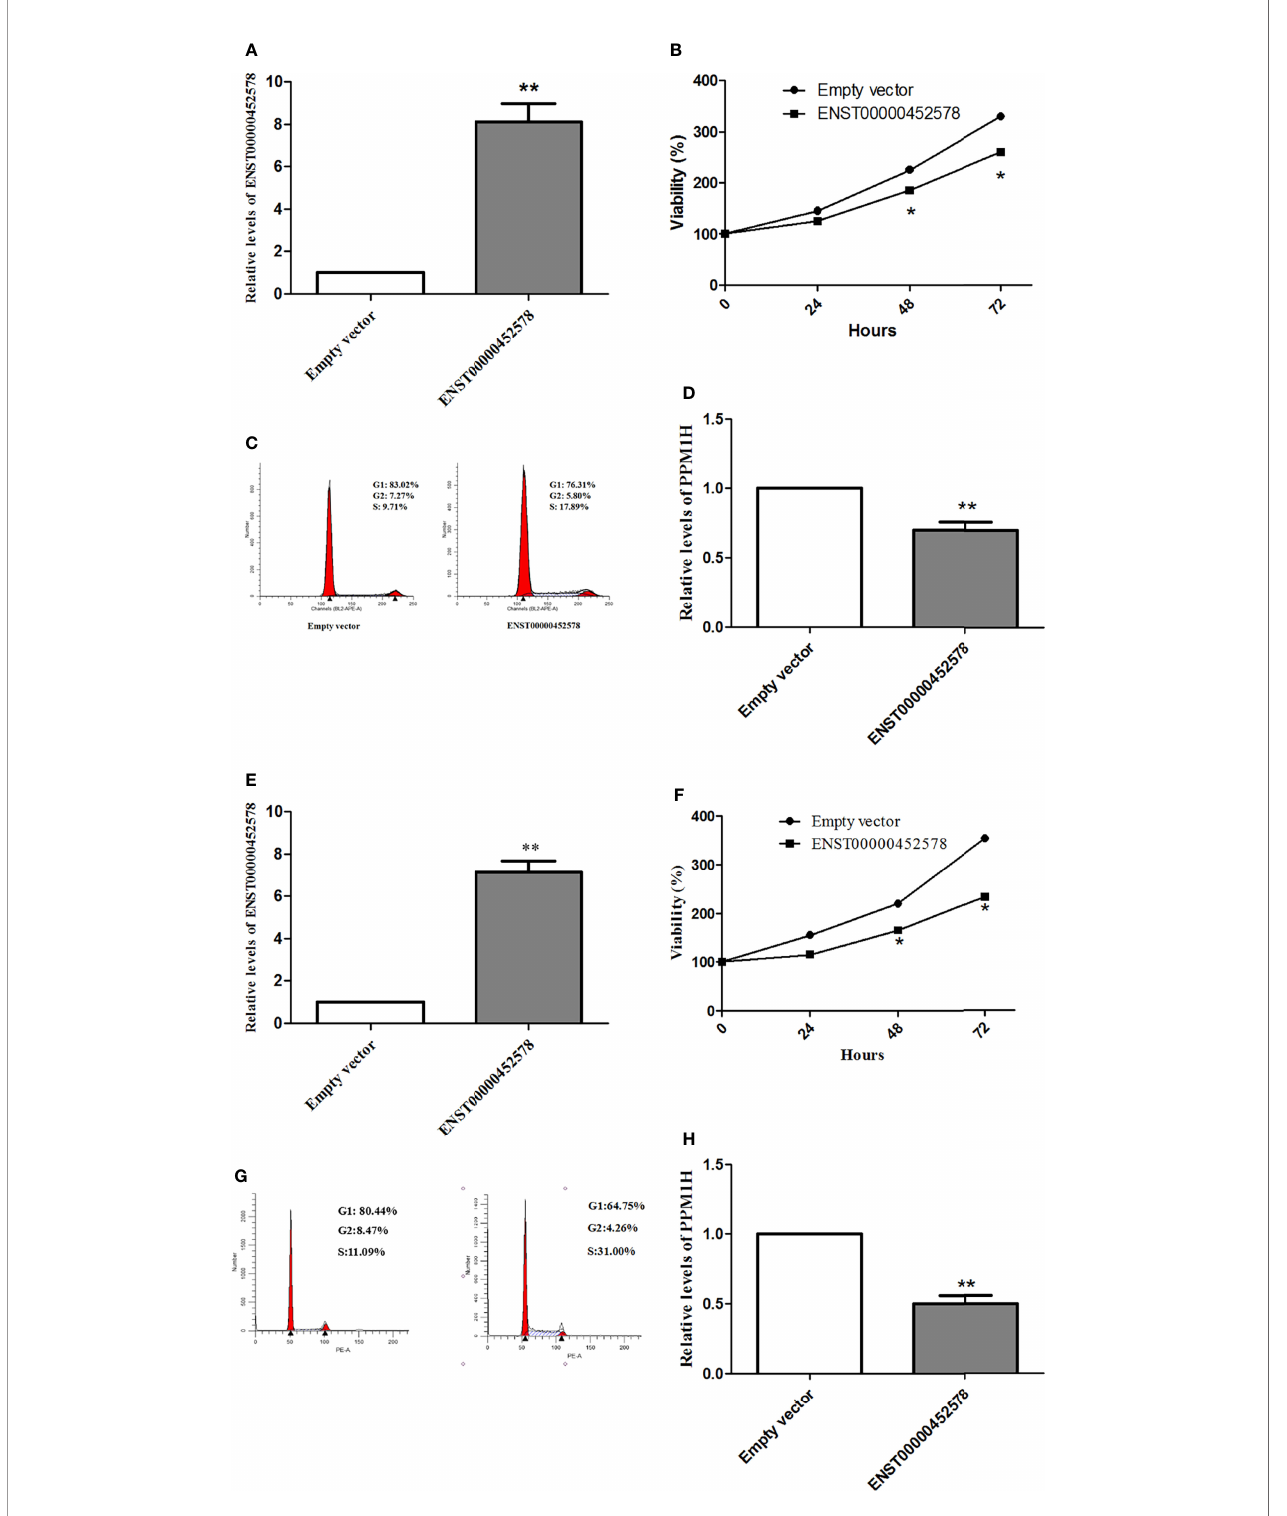
FIGURE 4 | Functional analysis of the lncRNA ENST00000452578 in the PTC cell line TPC-1 (A – D) and K1 (E – H) . (A, E) , cells were transfected with the ENST00000452578 overexpression plasmid and validated by qRT-PCR; (B, F) , MTT assays were performed to detect the cell growth at the indicated time points after transfection; (C, G) , cell cycle analysis was performed in 48h after transfection; (D, H) , qRT-PCR was used to detect the PPH1M expression in 48h after transfection. Data are presented as the mean ± SD, n=3. *P < 0.05 vs. control, **P < 0.01 vs.